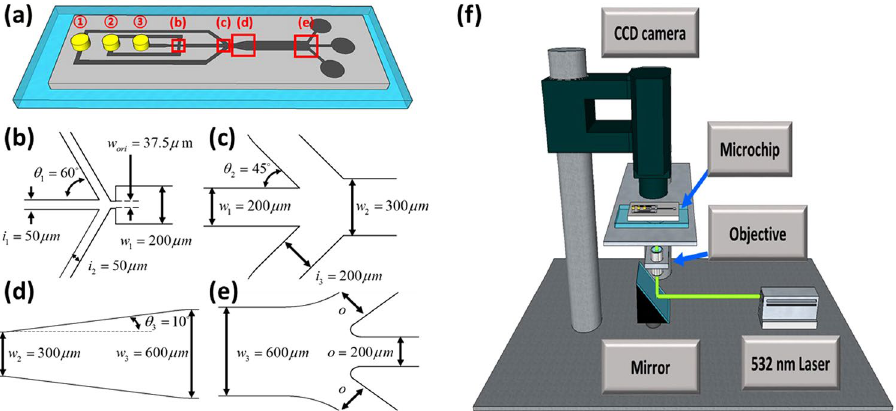
Figure 5. Experimental setup of ( a ) the microfluidic chip schematic with three inlets and three outlets; ( b ) the dimensions for junction 1, which is used for droplet generation; ( c ) the dimensions for junction 2, which is used to control droplet velocity and intervals; ( d ) the dimensions for expansion; ( e ) the dimensions for junction 3, which is used for droplet routing experiments; and ( f ) the experimental setup for repulsive thermocapillary